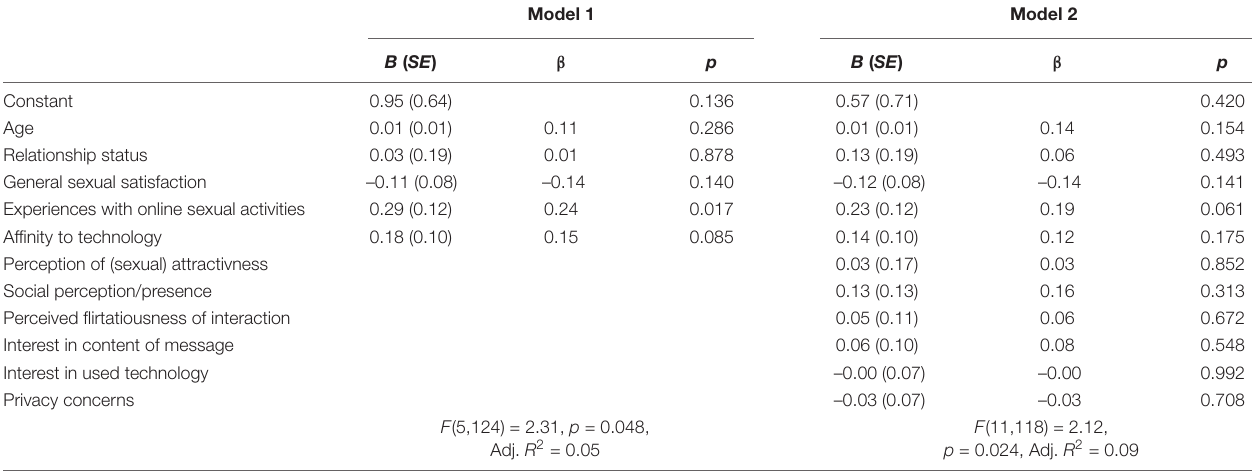
TABLE 2 | Hierarchical regression analysis of additionally heard flirtatious messages of the voice assistant.